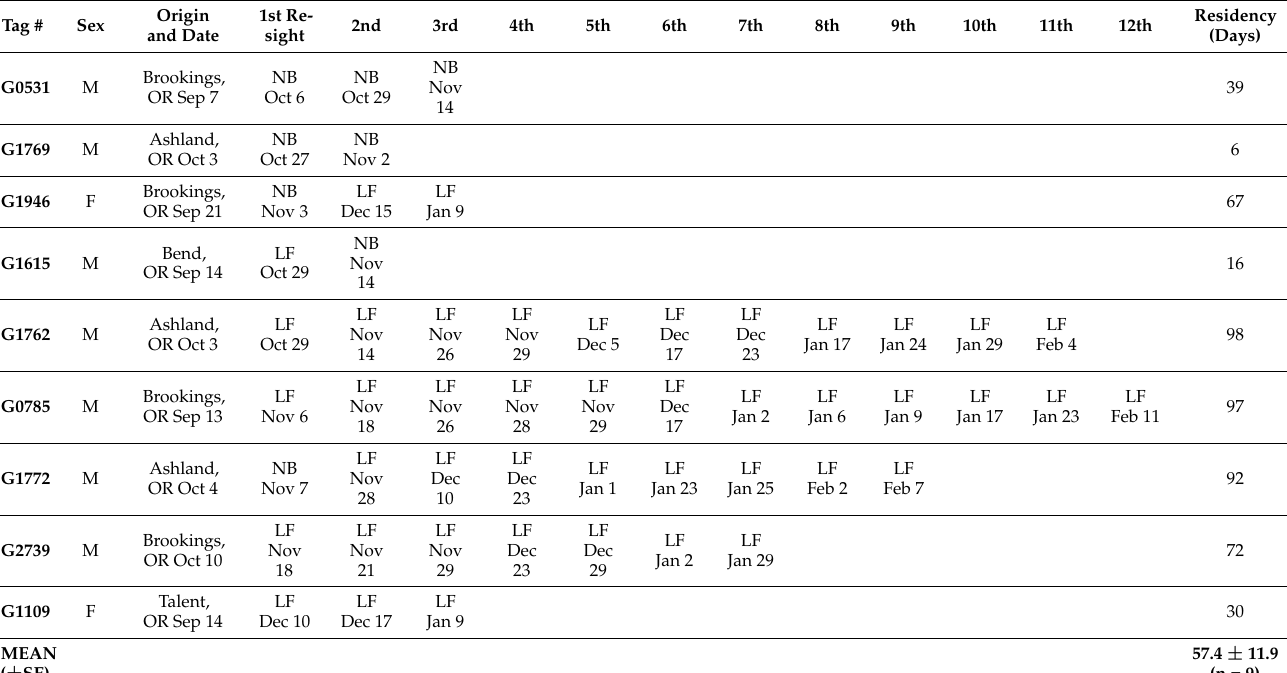
Table 7. Re-sighting data for captive-reared tagged monarchs in California in 2019. All data from overwintering sites in Santa Cruz: NB = Natural Bridges State Beach, LF = Lighthouse Field State Beach, ML = Moran Lake. Residency = period spent at overwintering site (s).